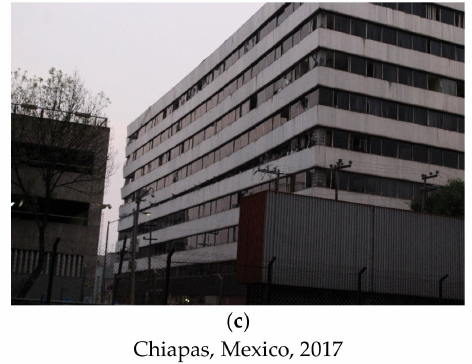
Figure 14. Damage type 7—example of a partial collapse of the upper-storeys: ( a ) general view; ( b ) detail of the column shear failure; ( c ) detail of an 8-storey building with soft-storey collapse at 4th storey.